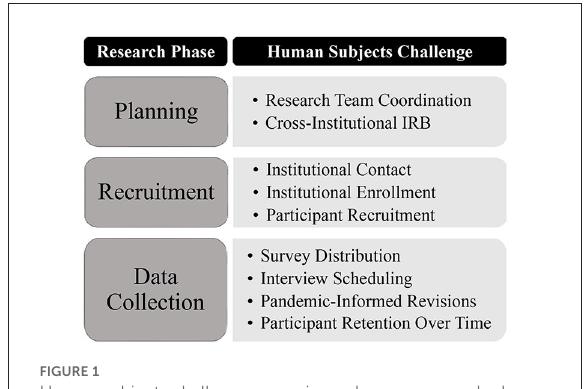
FIGURE1 Human subjects challenges experienced across research